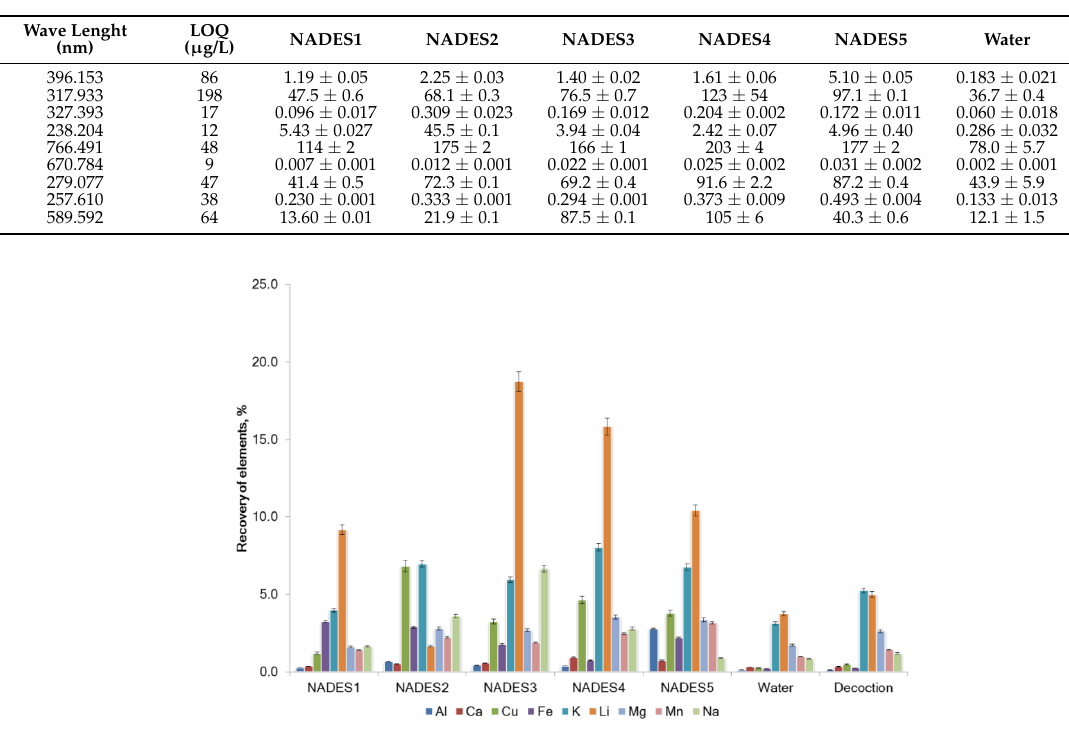
Table 2. The concentrations of elements (mg/kg) in samples of Glycyrrhiza glabra extracts (mean ± SD, n = 3).